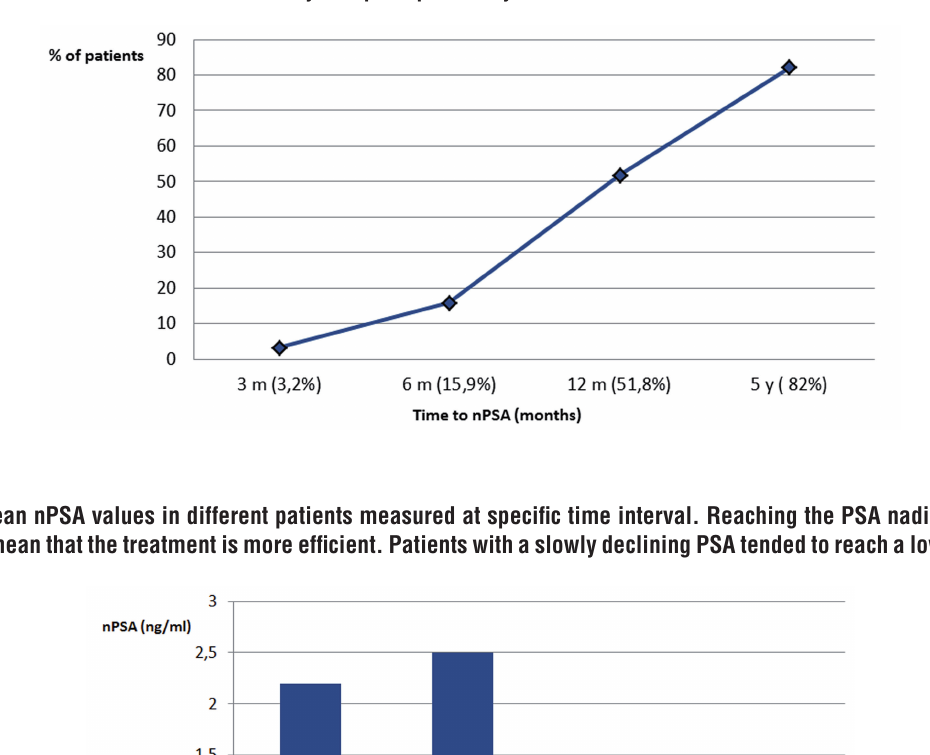
Figure 2 - % patients reaching nPSA at specific intervals. 50% of the patients reached the nadir 1 year after brachytherapy, 82% of the patients reached the PSA nadir 5 years postoperatively.